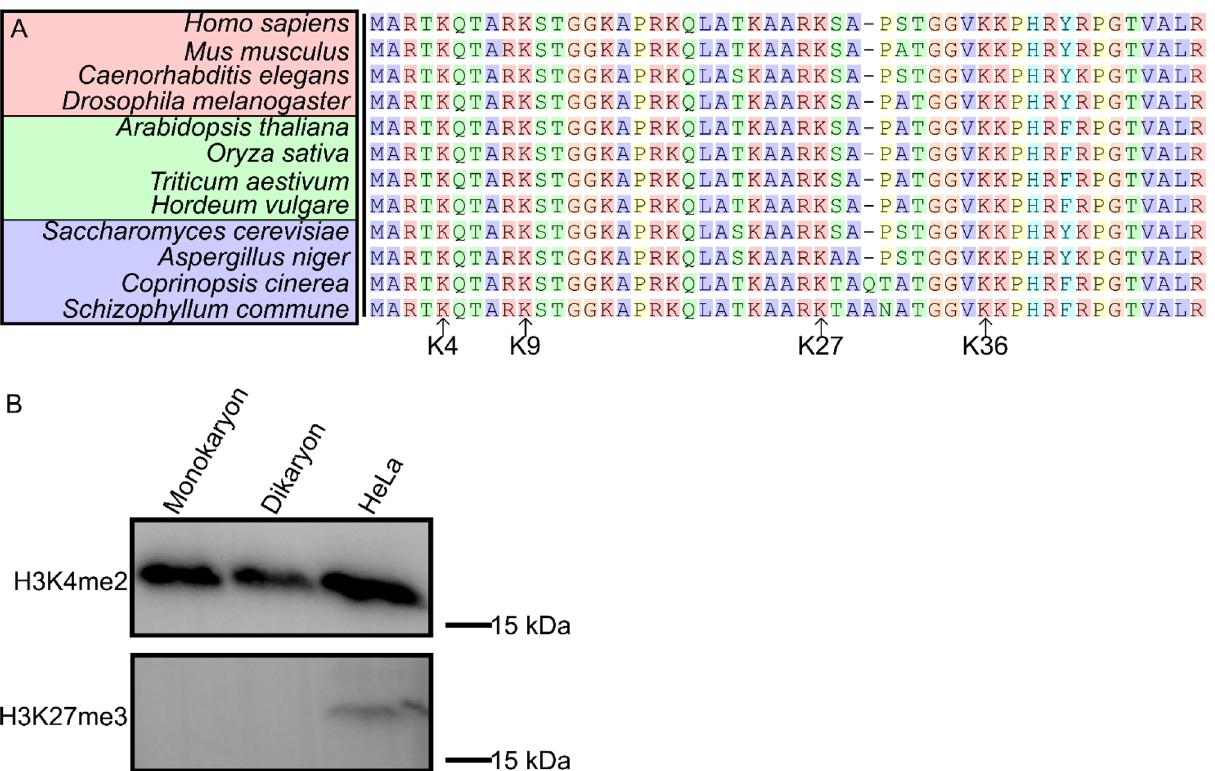
Figure 1. Recognition of methylation on histone H3 by mammalian anti-H3K4me2 and H3K27me3. ( A ) Sequence alignment of the 50 N-terminal amino acids of histone H3 from 12 well-studied species across the kingdoms of animalia (red), plantae (green) and fungi (blue). The four primary lysine methylation sites are indicated. Amino acids are color-coded according to the Clustal X color scheme 48 . While the lysines K4, K9, K27 and K36 are conserved across all species, immediately downstream of K27 several substitutions and an insertion have occurred in the basidiomycete fungi ( C. cinerea and S. commune ). This is further confirmed in a larger data set of 57 species, including 49 fungi (Supplementary Fig. 1). ( B ) Western blot for H3K4me2 and H3K27me3 on a monokaryon and dikaryon of 88 h old and HeLa whole cell lysate. The presence of the bands indicates that H3K4me2 can be detected by an antibody raised against human histone H3 with lysine 4 dimethylation, while H3K27me3 cannot be detected by an antibody raised against human histone H3 with lysine 27 trimethylation. The full-length blots of H3K4me2 and H3K27me3 are represented in Supplementary Figs. 2 and 3,